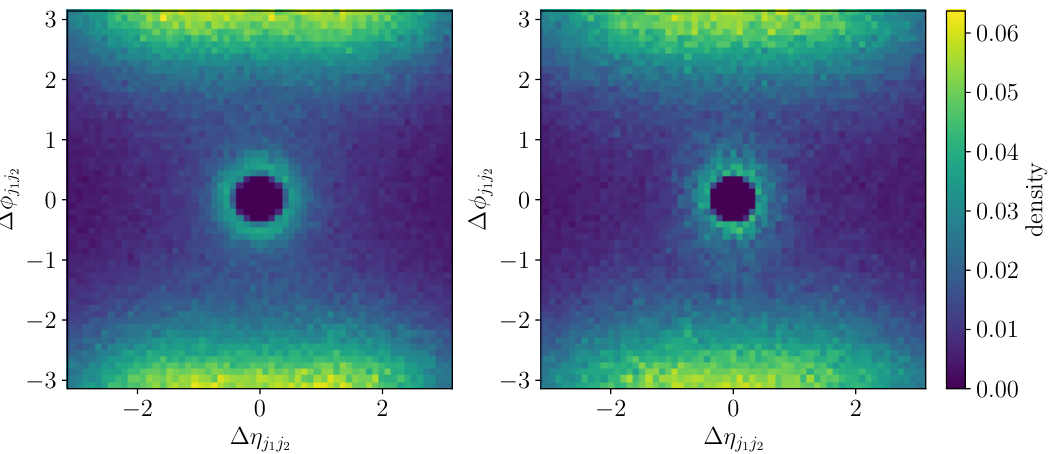
Figure 2: Jet-jet correlations for events with two jets. We show truth (left) and INN- generated events